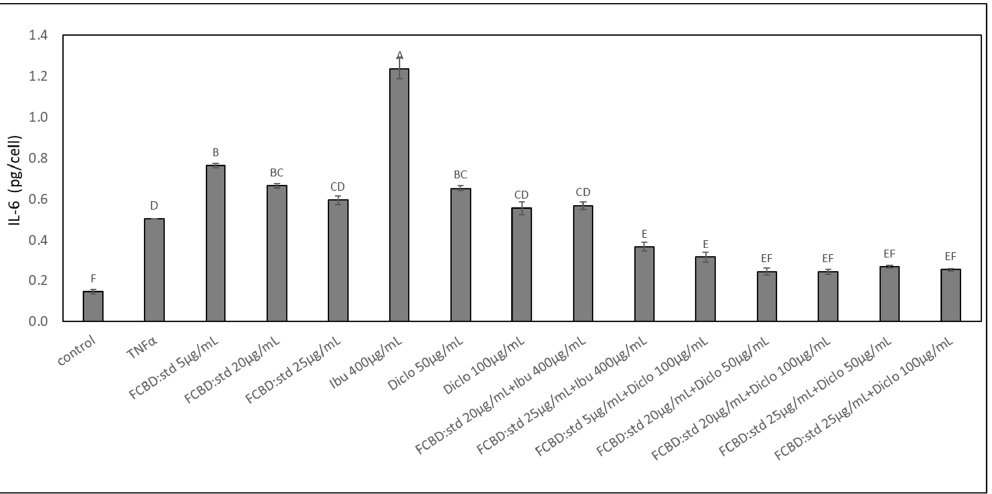
Figure 4. The effect of treatments with FCBD:std and diclofenac (Diclo) or ibuprofen (Ibu) on IL-6 levels in co-cultures of A549 and differentiated KG1 cell lines. Control is vehicle control (1% methanol; 1% DMSO vehicle control is not significantly different from 1% methanol, not shown). TNF α is solvent control + TNF α . Means ± SE ( n = 3) are shown. Levels of means with different letters are significantly different from all pairs’ combinations according to Tukey–Kramer honest significant difference (HSD; p ≤